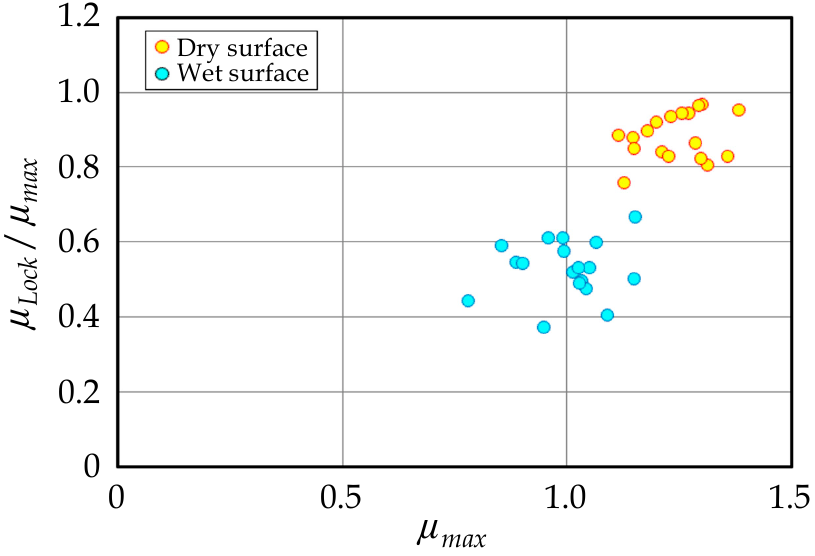
Figure 5. Ratio of lock μ to peak μ .